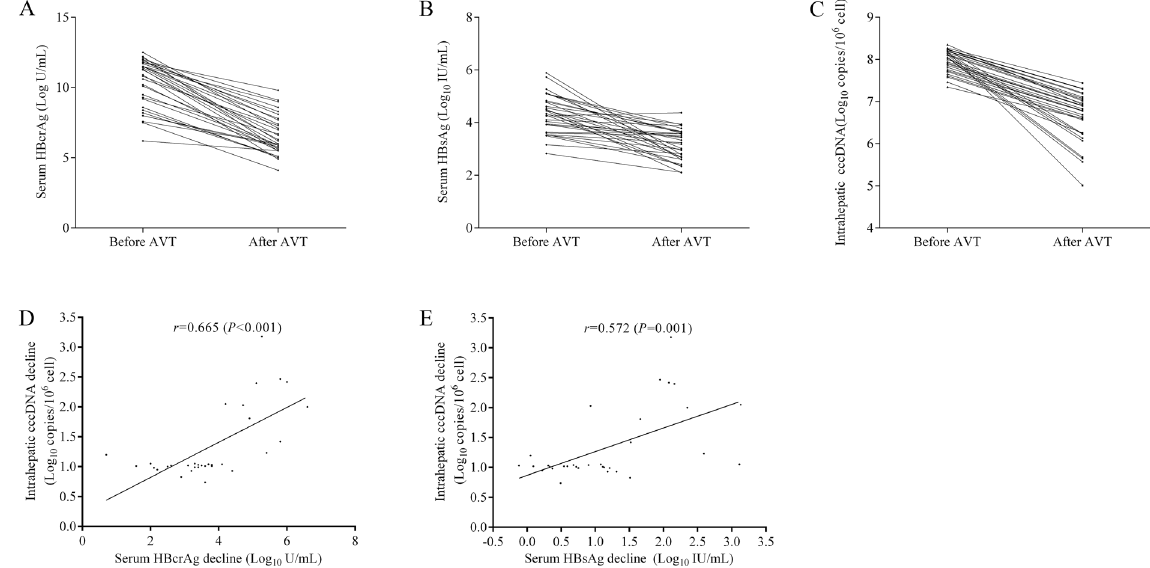
Figure 5. Dynamic changes of serum qHBcrAg ( A ), qHBsAg ( B ) and intrahepatic cccDNA ( C ) before and after antiviral therapy; and the correlations of dynamic changes of serum qHBcrAg ( D ) and qHBsAg ( E ) with intrahepatic cccDNA